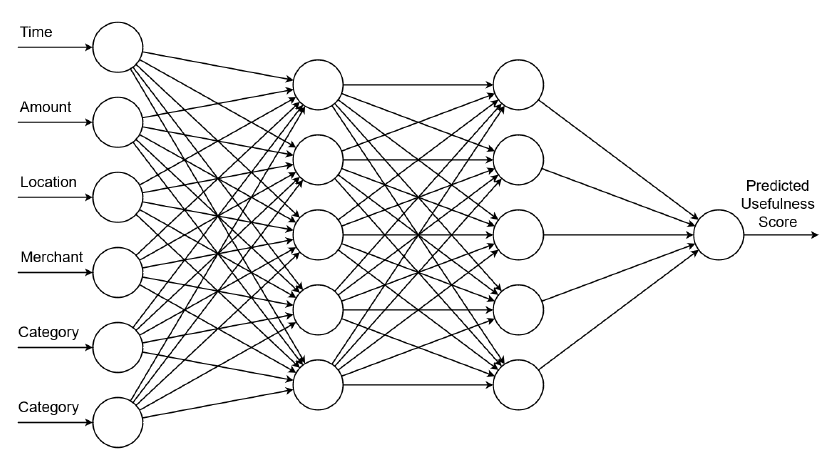
Figure 4. A feedforward neural network with one output.